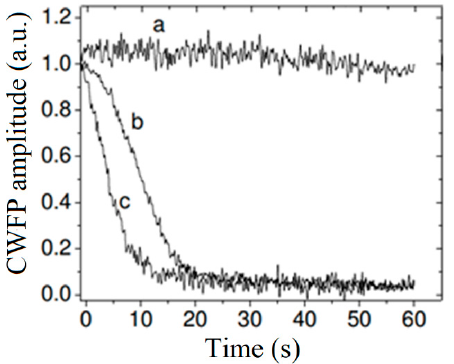
Figure 7. Amplitude of CWFP signal of the irradiated methacrylates samples with phenyl-propanedione (PPD, a ), monoacylphosphine oxide (MAPO, b ) and canphorquinone (c) photoinitiators.